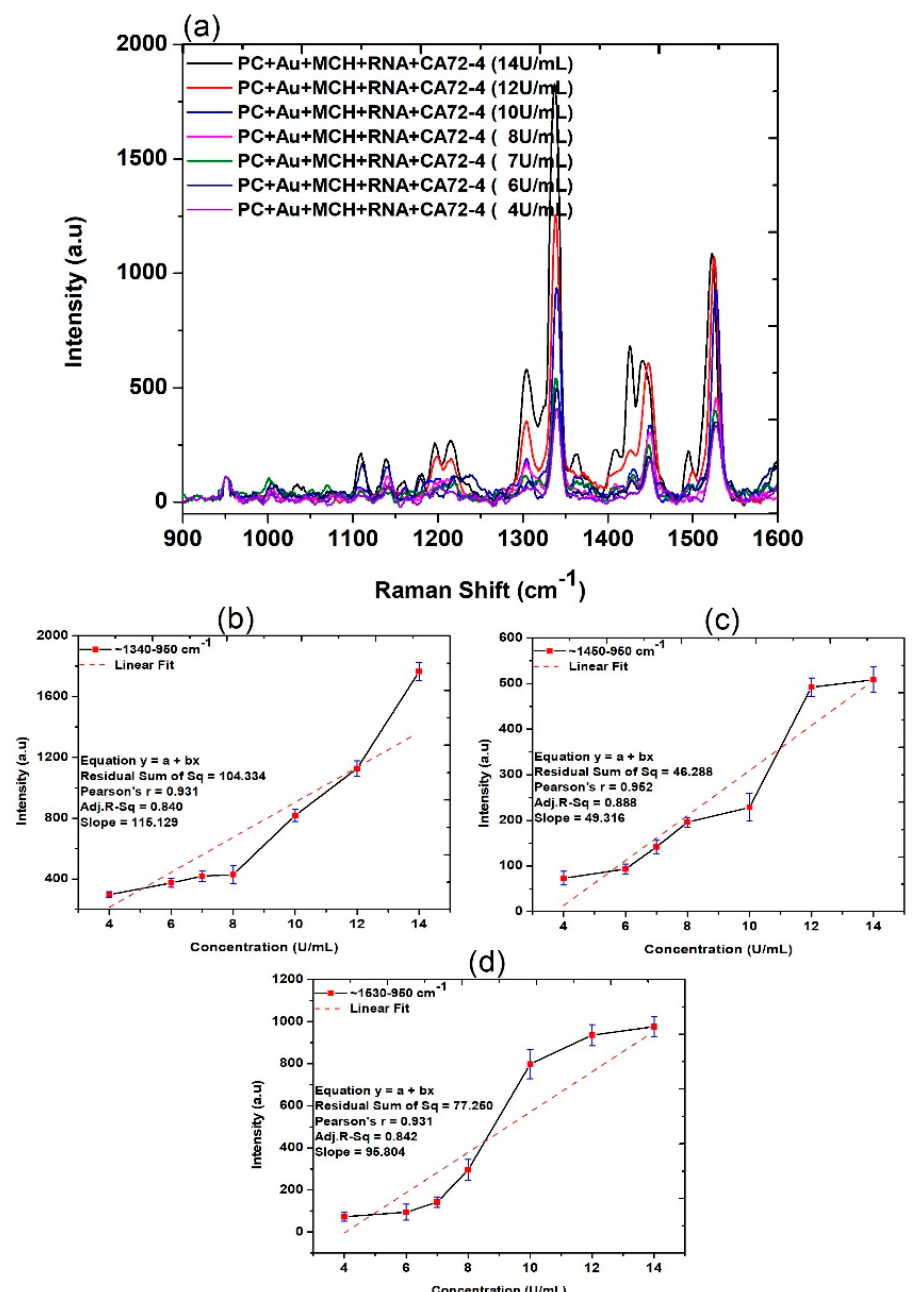
Figure 3. Raman spectra and quantitative analysis of adsorption of different concentrations of cancer antigen CA 72-4 on our electrochemical sensor. ( a ) Raman spectra of different concentrations of CA 72-4. ( b ) Plots of the intensity of the band calculated difference between two maxima regions of around 1340–950 cm − 1 . ( c ) Plots of the intensity of the band calculated difference between two maxima regions of around 1450–950 cm − 1 . ( d ) Plots of the intensity of the band calculated between two maxima regions of around 1530–950 cm − 1 .